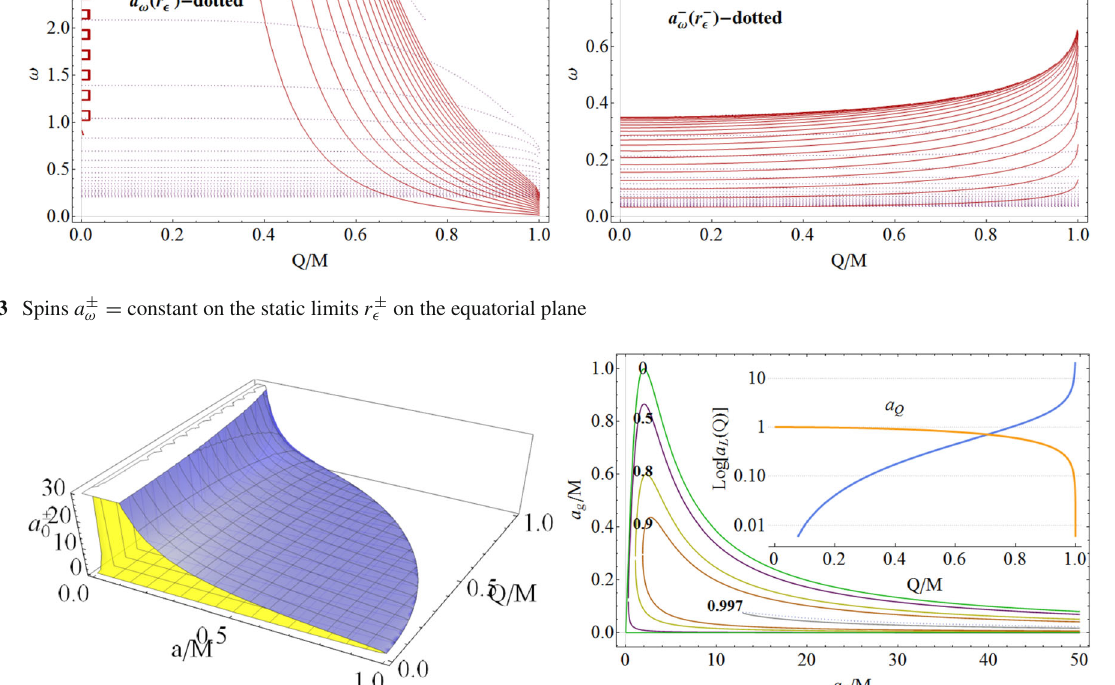
Fig. 24 Leftpanel:threedimensionalplotof a 0 / M ,Eq.(38),asafunc- tion of a / M and the charge Q / M . Right panel: spin a g / M as a function of a 0 / M for different charge to mass ratios Q / M . Inside panel: plot of